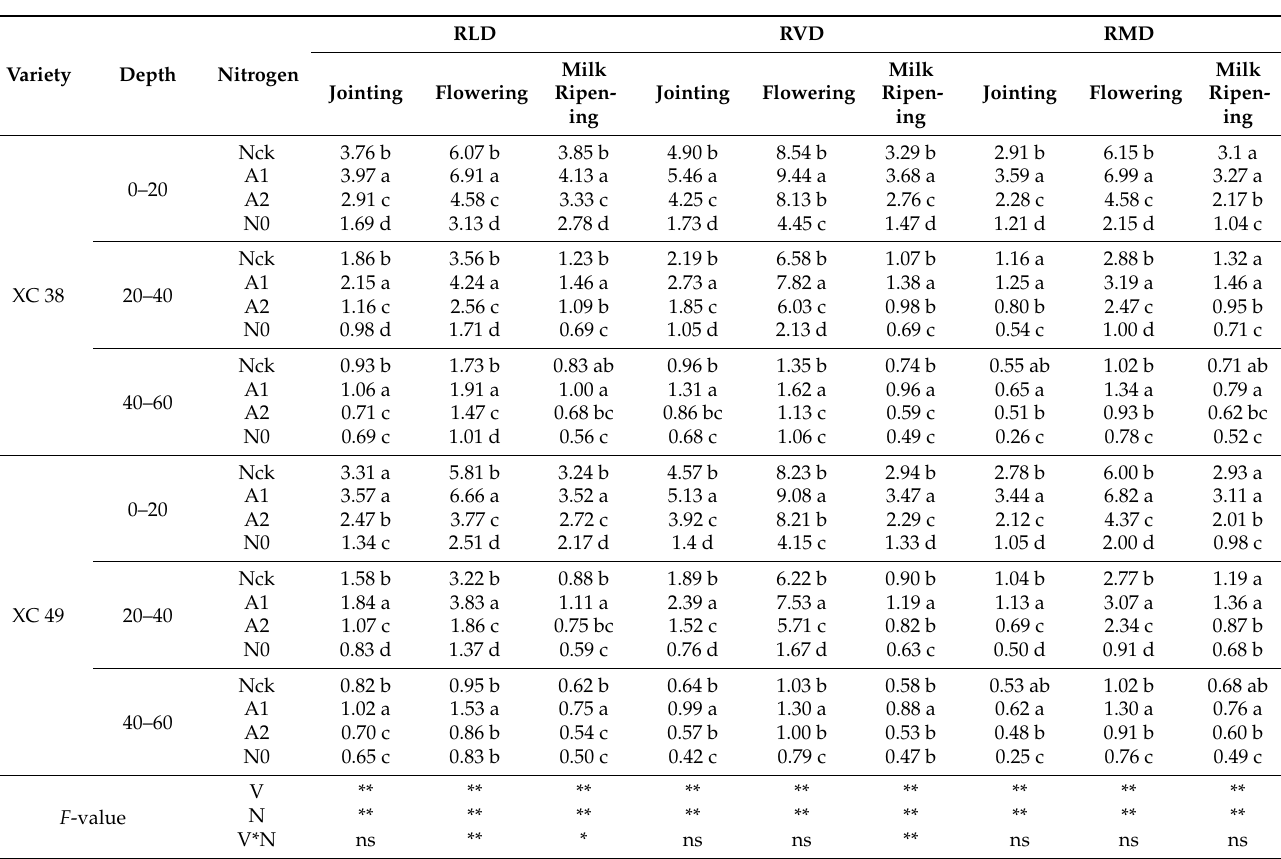
Table 2. Effect of different nitrogen application rates on the root morphology of drip-irrigated spring wheat in